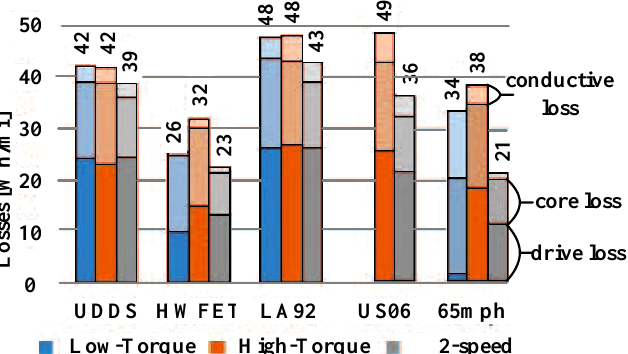
Figure 7. The measured copper, core and drive (converter) losses per mile for three different ma- chine/gearbox combinations in 4 drive cycles and constant speed of 65 mph operation reported in [89].